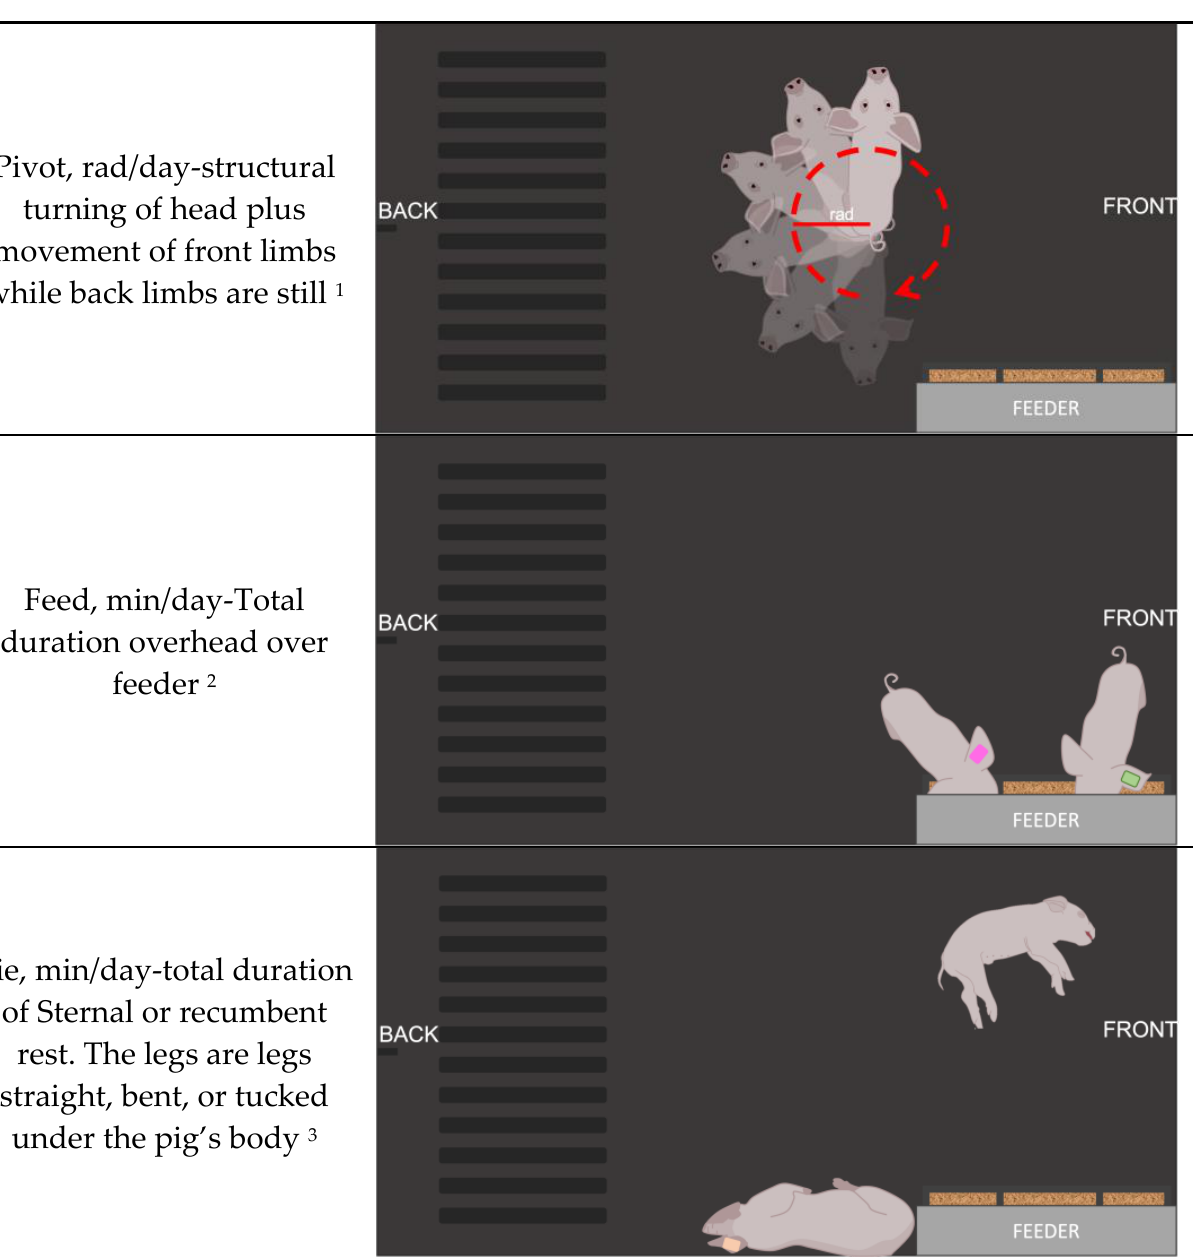
Figure 2. Ethogram used by the precision technology (NU track ) to automatically track nursery pig behavioral data. 1 Pivot, rad/day- structural turning of head plus movement of front limbs while back limbs are still [24]; 2 Feed, min/day- Total duration overhead over feeder [25,26]; 3 Lie, min/day- total duration of Sternal or recumbent rest. The legs are legs straight, bent, or tucked under the pig’s body [22].